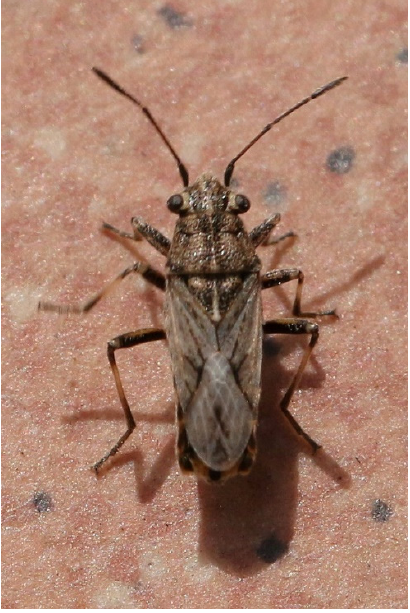
Figure 8. Ortholomus punctipennis (Herrich-Schäffer 1838; photo F.